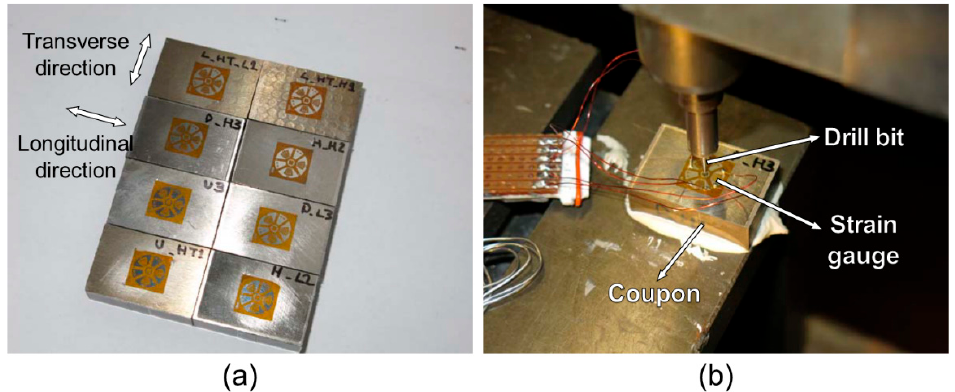
Figure 3. Images showing ( a ) strain gauge installation and ( b ) incremental hole drilling. The longitudinal and transverse directions are shown in ( a ).